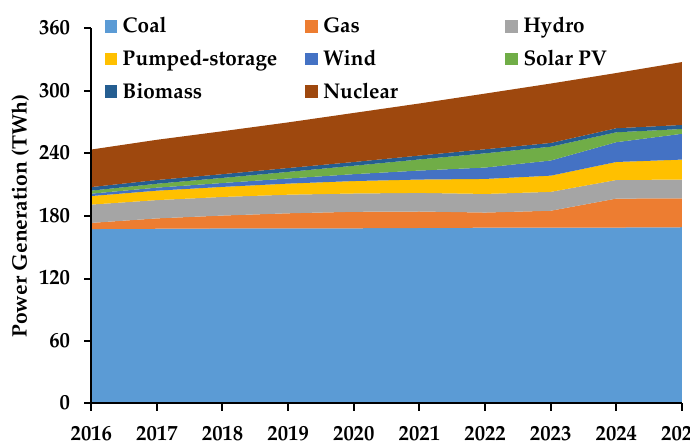
Energies 2018 , 11 , x FOR PEER REVIEW Figure 3. Power generation of different plants in the planning horizon. Figure 3. Power generation of different plants in the planning horizon.